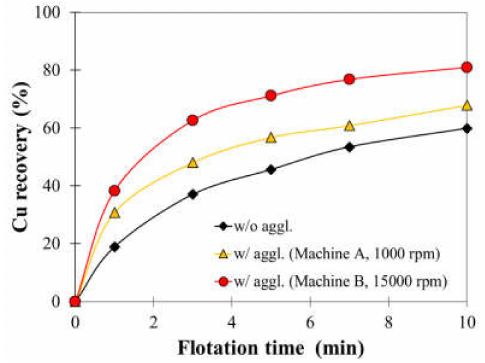
Figure 4. Cu recovery without agglomeration and with agglomeration using machine A (1000 rpm) and machine B (15,000